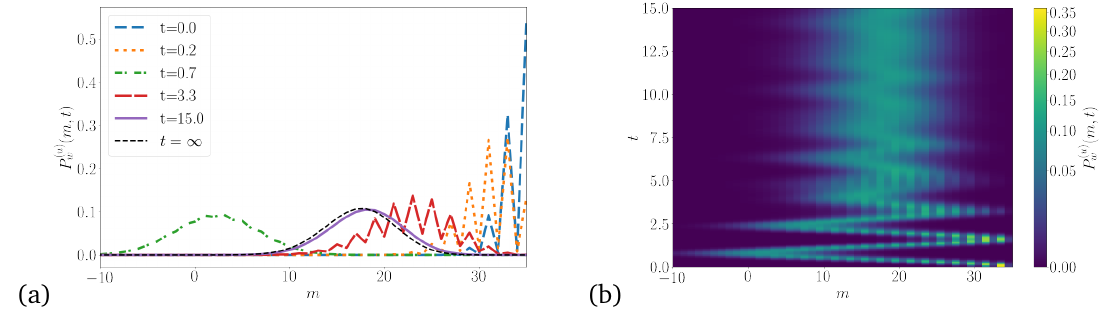
( m , t ) at times t = 0,0.2,0.7,3.3,15.0 Figure 12: (a) Probability distribution P ( u ) w after a quench from h = 3 to h = 0.2 for subsystem size (cid:96) = 70. (b) Probability ( m , t ) for the same distribution P ( u ) w